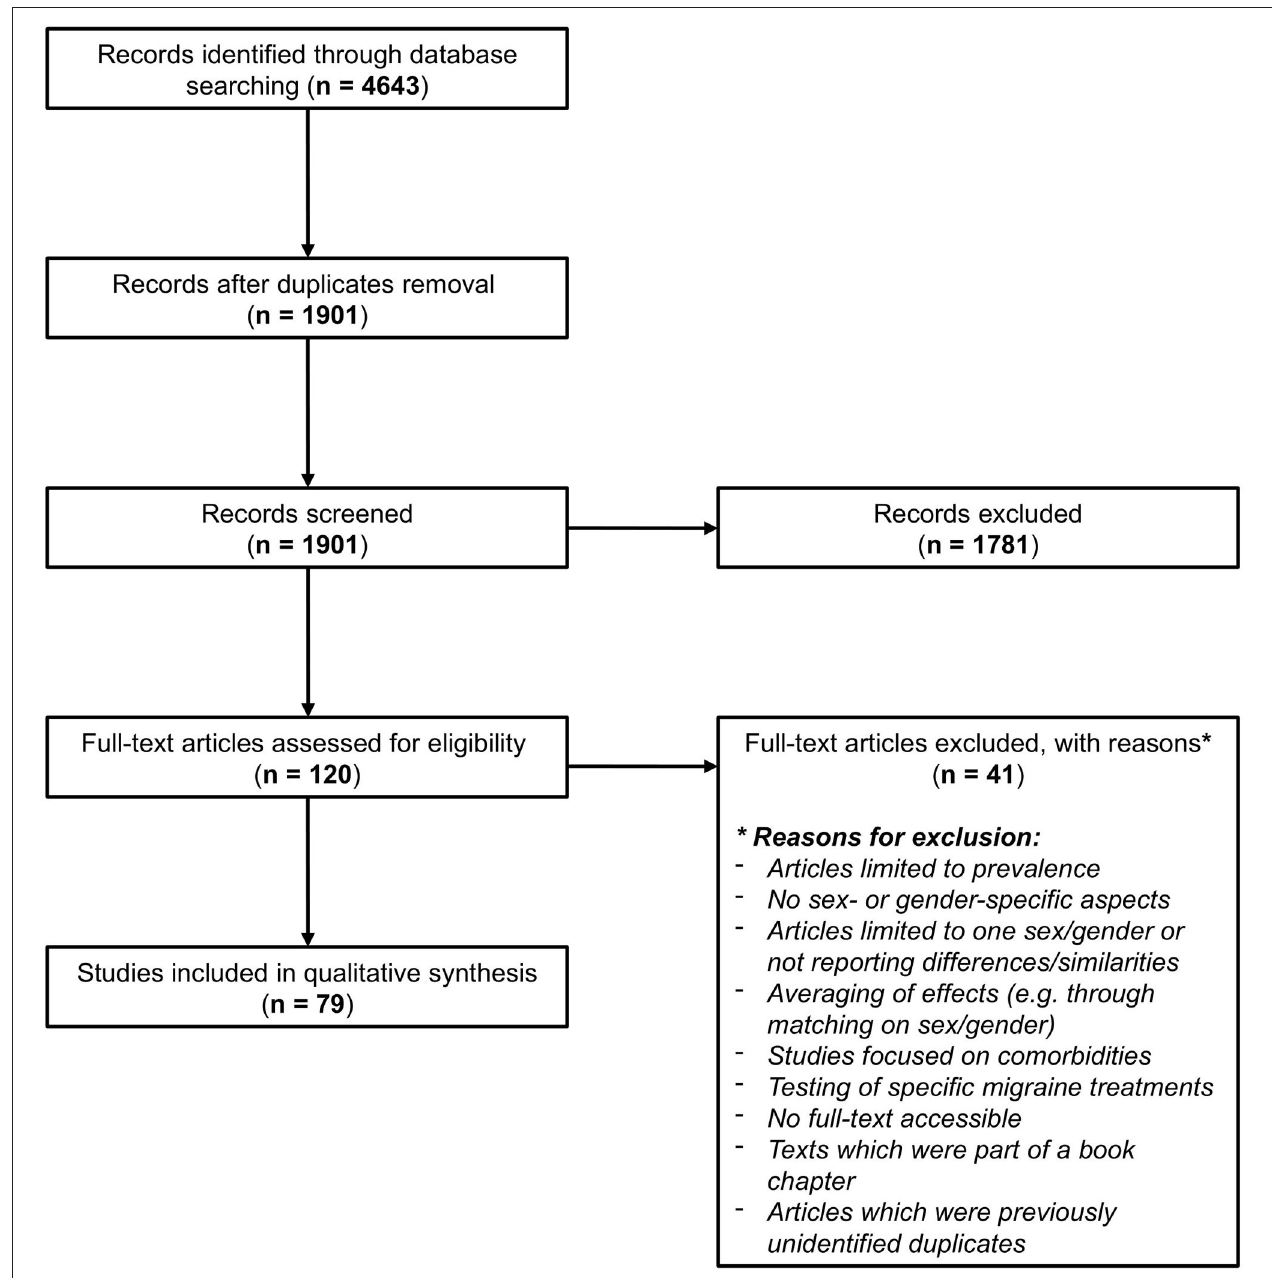
FIGURE 1 | Flowchart of the review process, modified from PRISMA 2009 Flow Diagram